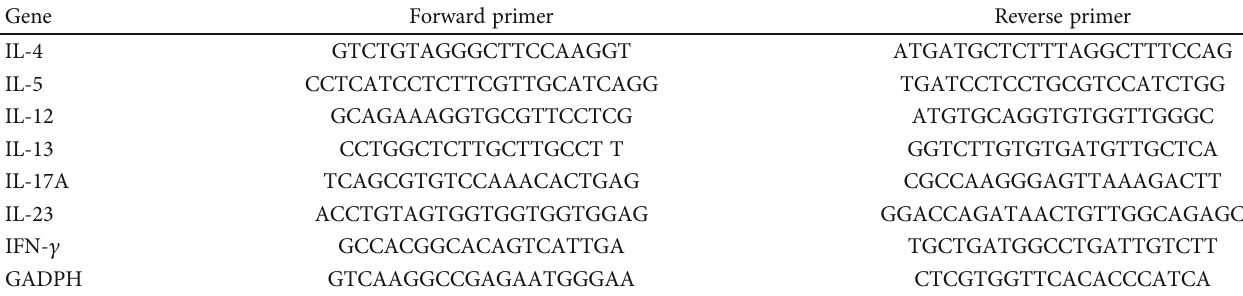
Table 1: Primer sequences for quantitative real-time polymerase chain reaction